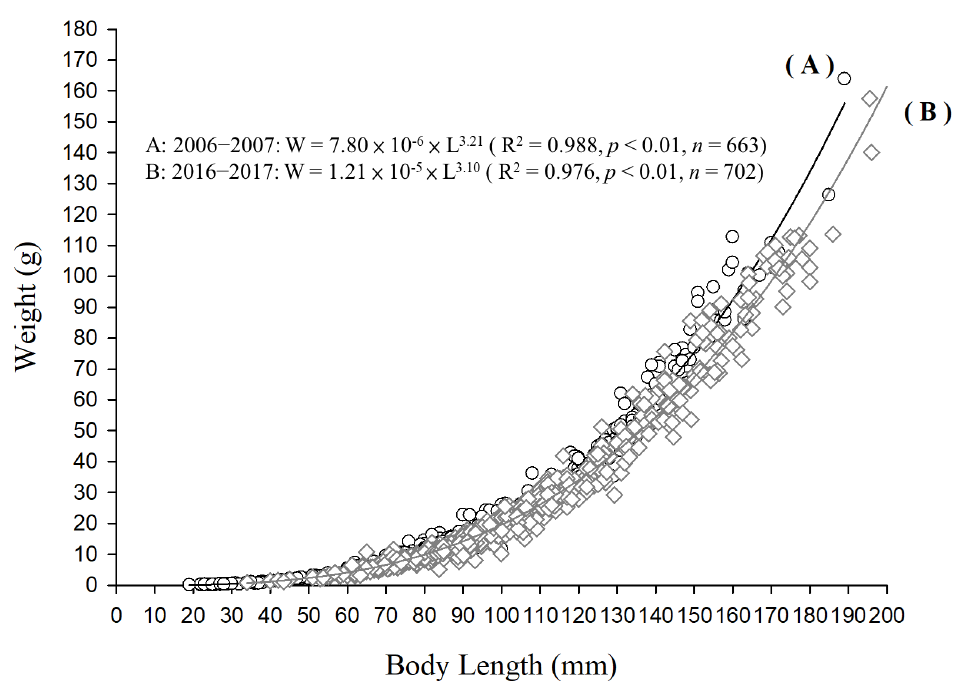
Figure 2. Relationship between body length and weight of Johnius belengerii : (( A ): 2006–2007, ( B ): 2016–2017) in Xiamen Bay. ( B ): 2016–2017) in Xiamen